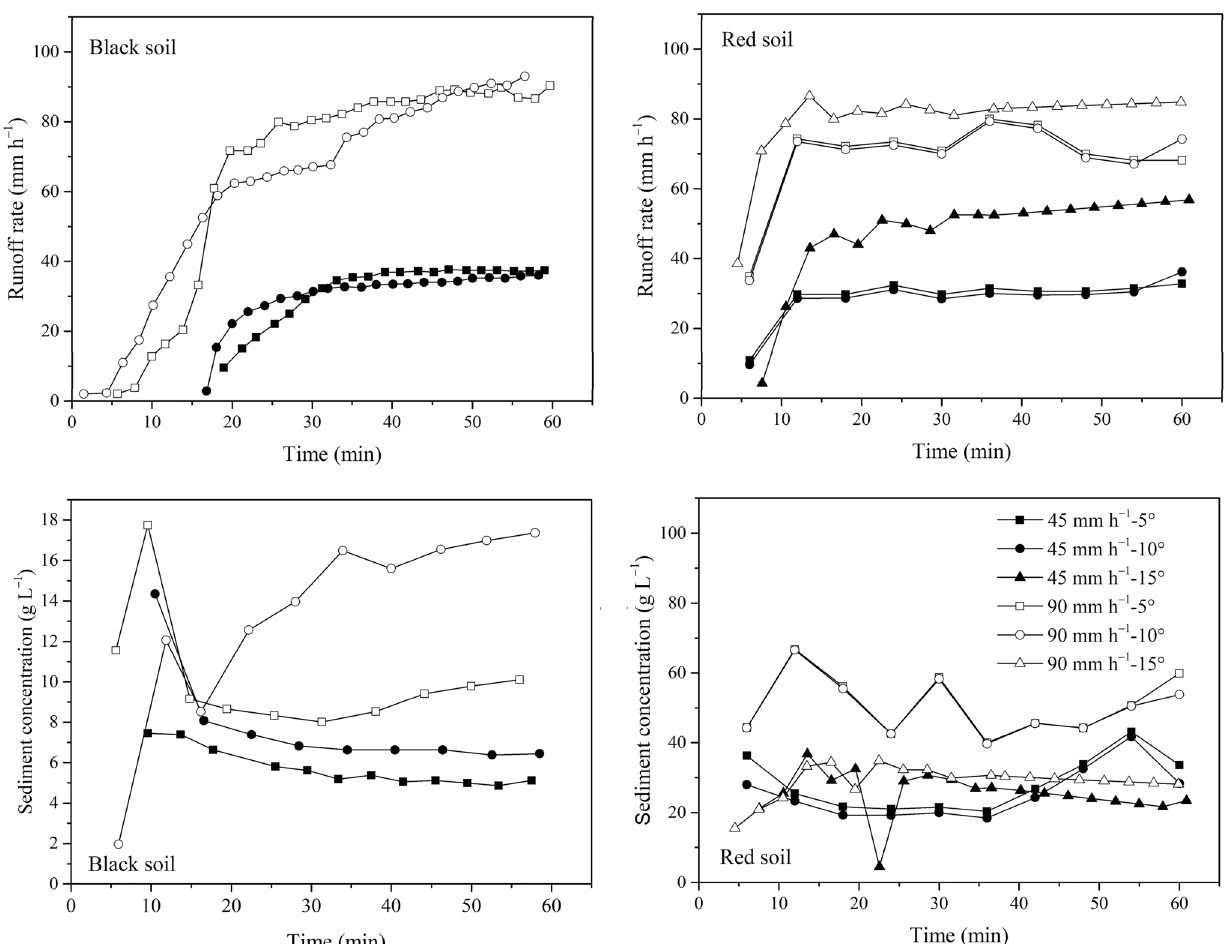
Fig. 2 Temporal variations of runoff rate and sediment concentration for black soil and red